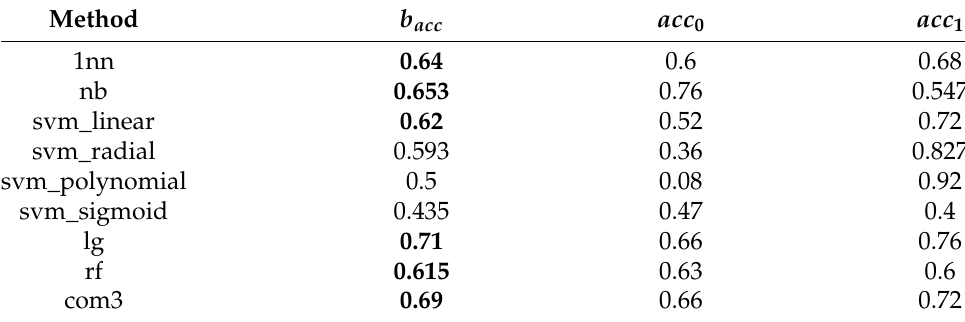
Table 11. Summary of results for data.bee3.3 with baseline correction.